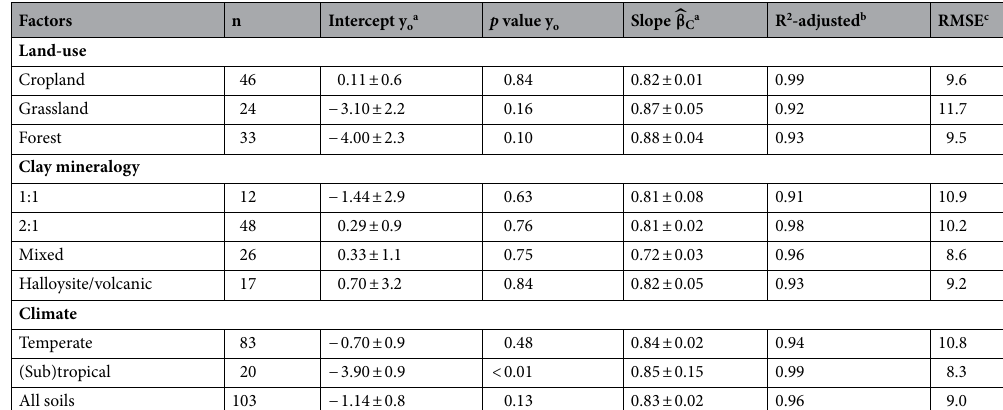
(cid:31) β C ω, where y is the (cid:31) β C were all